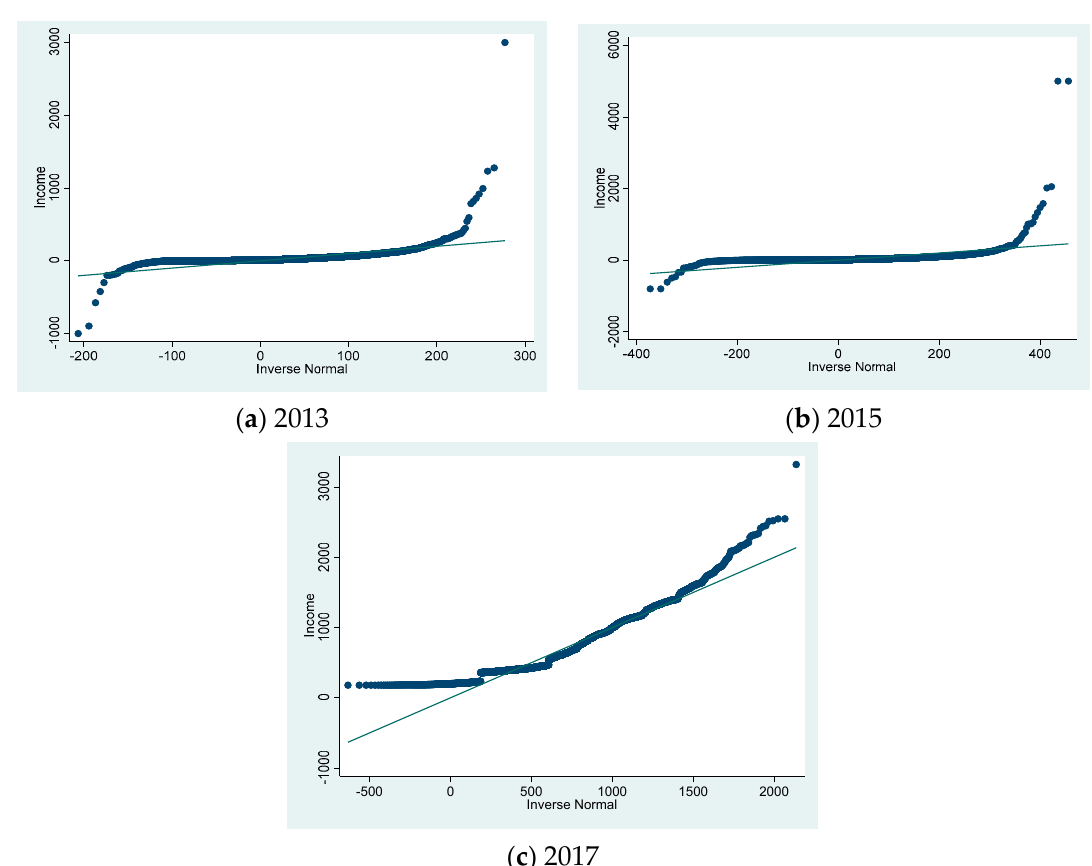
Figure 1. The normal quantile map of rural household income in different years that ( a – c ) describe the situation in 2013, 2015, and 2017, respectively.